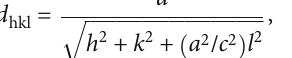
Figure 3: The structural strain of SnO Ni as a function of the aluminum